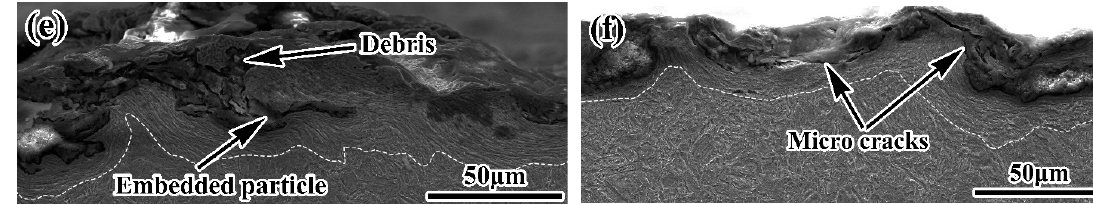
Figure 8. The characteristics of wear subsurface layers of the test steels tempered at different temperatures: ( a ) as-quenched; ( b ) 200 °C; ( c ) 240 °C; ( d ) 260 °C; ( e ) 300 °C; ( f ) 400 °C.